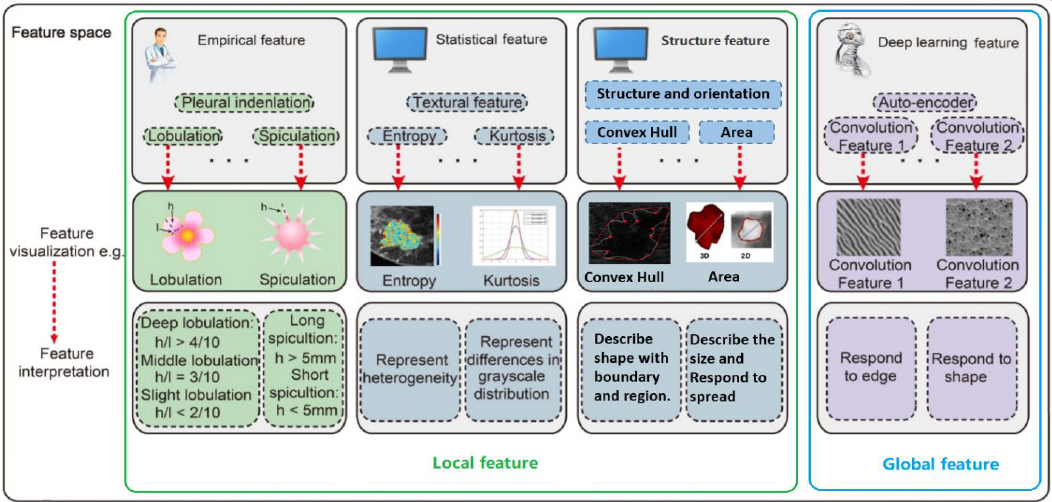
Figure 1. Radiomic analysis simultaneously explores empirical features, statistical features, structure features and deep learning. features and deep